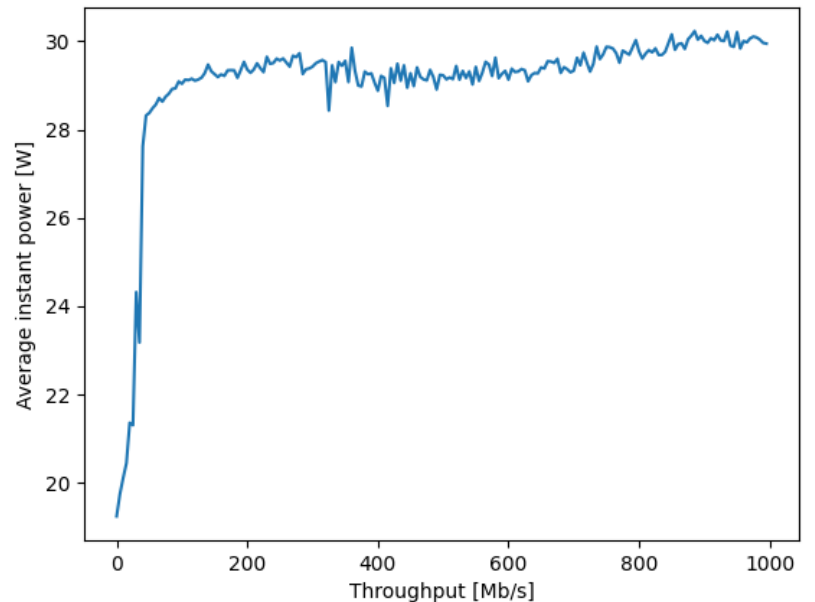
Figure 2. The dependence of the instantaneous power consumption on the traffic load of an Intel NUC that is used as a SDN switch or router. The y axis is the power consumption in Watts, averaged over 30 distinct measurements, against the traffic values provided in the x axis in